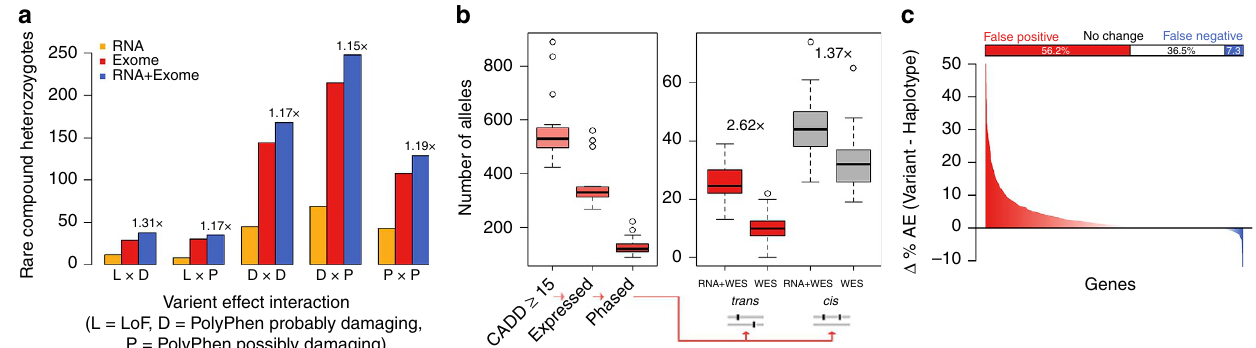
Figure 2 | Application of RNA-seq based haplotype phasing to studies of functional variants and allelic expression analysis. ( a ) Instances of compound heterozygosity involving rare (MAF o 0.01) loss of function (L), probably damaging (D) or possibly damaging (P) coding variants called using phase data generated by phASER with either RNA-seq reads, exome-seq reads, or both for 345 1,000 Genomes European individuals with Geuvadis LCL RNA-seq data. The fold increases in the number of compound heterozygotes resolved when RNA-seq data is included are indicated. ( b ) Example application of phASER to prioritize rare (alternative AF o 0.01 in 1,000 Genomes) recessive alleles in a medical genetics study that includes both WES and RNA-seq in a tissue of clinical relevance 17 . Boxplots show the number of heterozygous alleles per individual after these successive filtering steps were applied: CADD phred score Z 15, expressed in fibroblast RNA-seq data, phased with read backed phasing, involved in either trans or cis interactions with another deleterious variant (CADD Z 15) using RNA and exome data (RNA þ WES) or exome alone (WES). The fold increases from including RNA-seq data are indicated. ( c ) The difference in percentage of individuals with significant allelic imbalance (binomial test, FDR o 0.05) for each gene with a known heterozygous cis expression quantitative trait loci (eQTL) calculated by either summing all single variant read counts across haplotypes using population phasing, or by summing phASER haplotype blocks phased relative to each other with phase anchoring (Supplementary Fig. 7). Genes where an increase in the percentage of individuals with significant allelic imbalance is observed when summing single variant counts are coloured red, representing false positives, while those with a decrease, representing false negatives, are coloured blue. The bar plot above indicates the percentage of the 1,118 genes where allelic expression was measured that fall into each